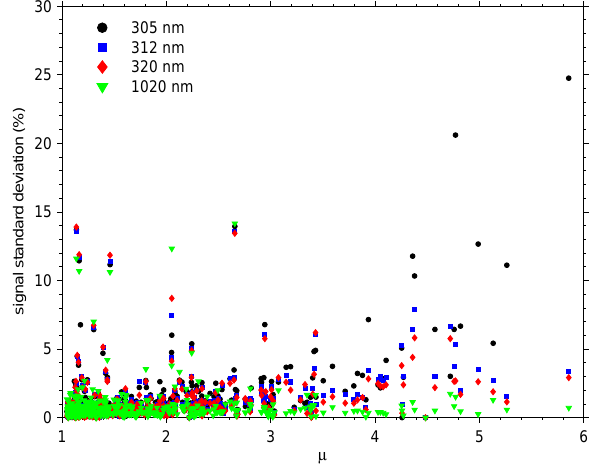
Fig. 3. Scatter plot of the standard deviation of the Microtops II signals at 305, 312, 320 and 1020nm against the standard deviation of AOD 1020